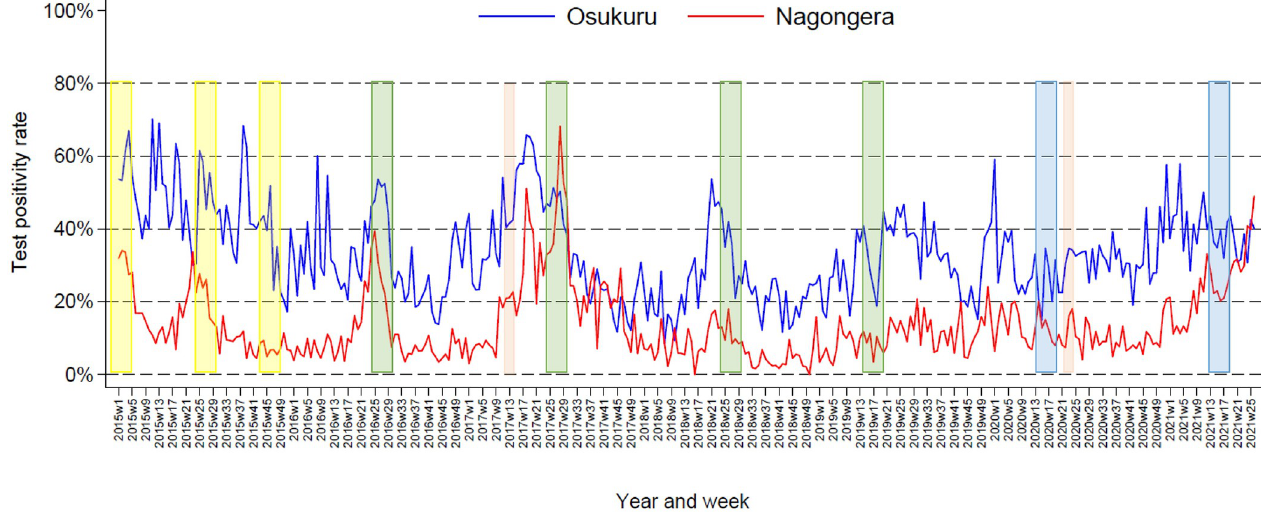
Fig 2. Temporal changes in test positivity rates estimated from routine health facility-based data (January 2015 –June 2021) from the interior of Tororo District (Nagongera Health Centre IV) and within the border area of Tororo District where the cohort study was conducted (Osukuru Health Centre III). (Pink bars signify rounds of mass LLIN distribution, yellow bars are rounds of IRS with bendiocarb, green bars are rounds of IRS with pirimiphos-methyl, and blue bars are rounds of IRS with Fludora